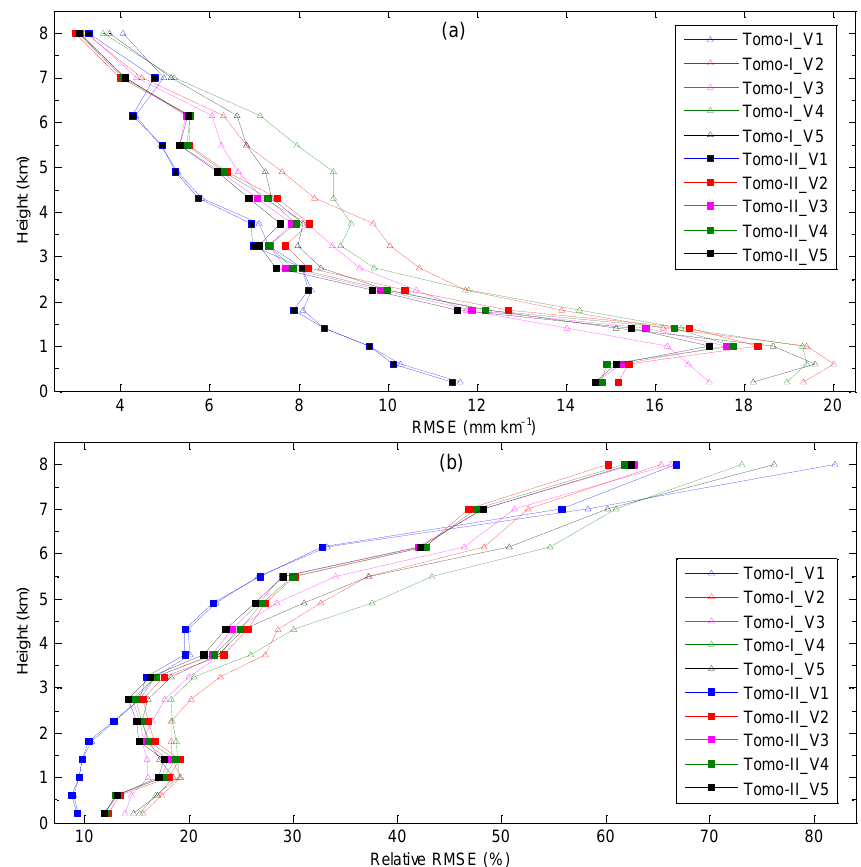
Figure 4. RMSEs (a) and relative RMSEs (b) of the differences between wet refractivity derived from radiosonde and tomography on different altitude layers during May to October